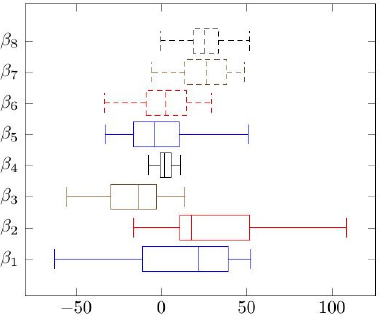
Figure 3. Box plot of the system’s parameters from the OLS Identification.